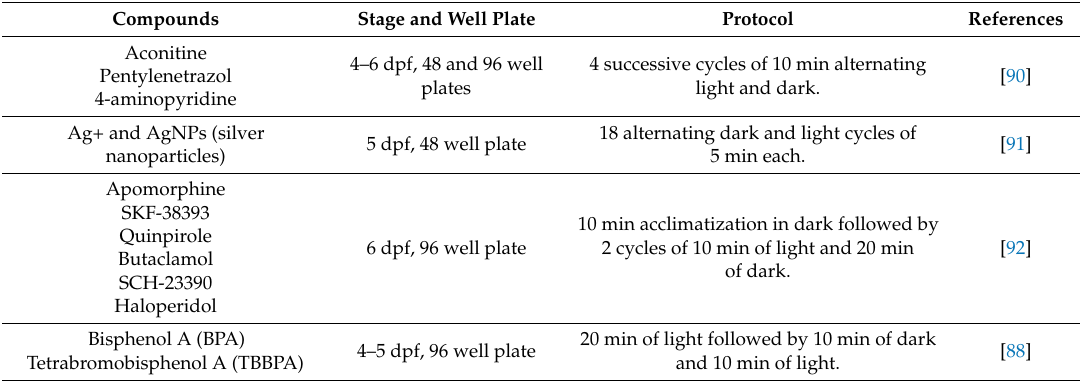
Table 1. Light-dark locomotion test protocols used by various studies for testing neuroactive compounds.